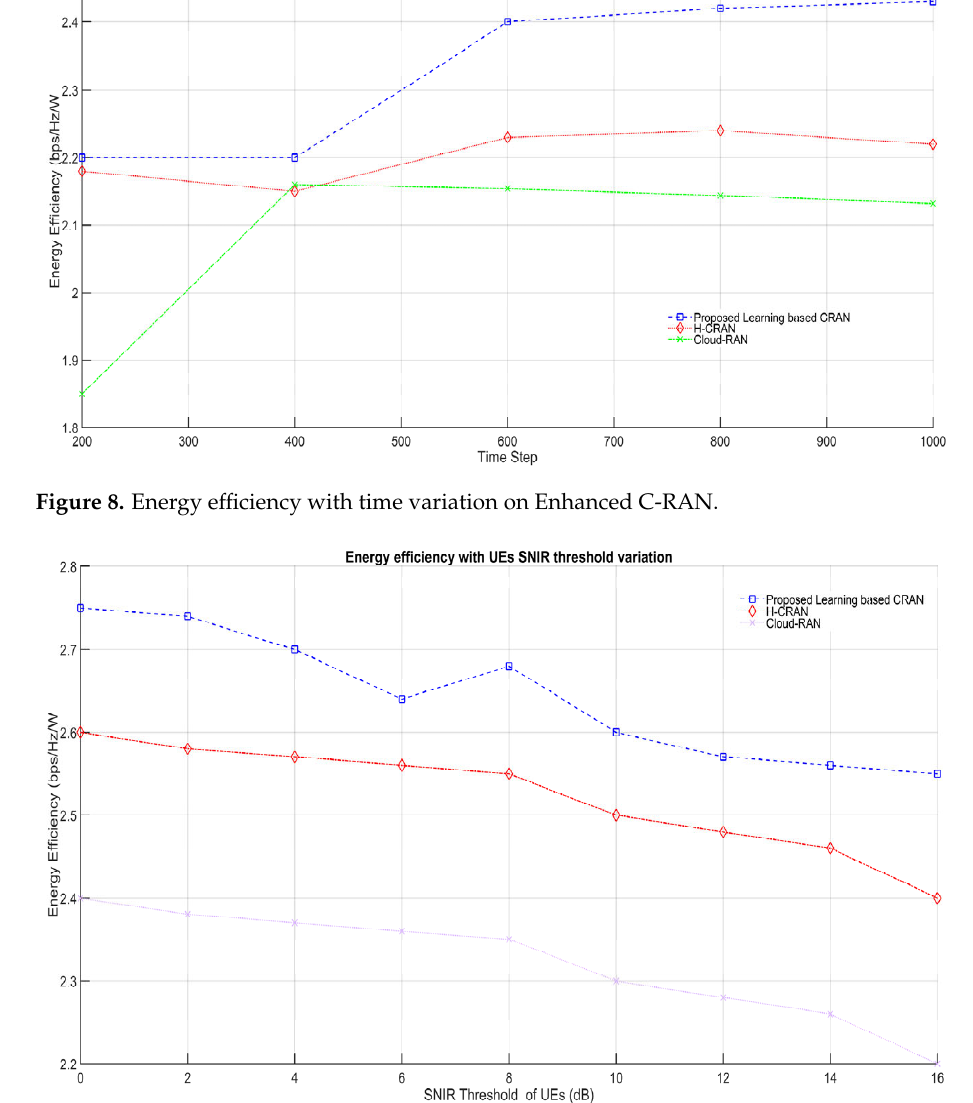
Figure 9. Energy efficiency with UE’s SNIR threshold variation.